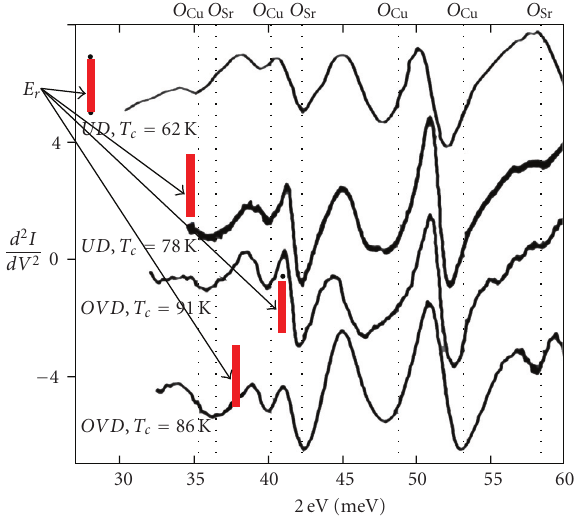
Figure 30: Second derivative of I ( V ) for Bi 2212 tunnelling junctions for various doping: UD—underdoped; OD—optimally doped; OVD—overdoped system. The structure of minima in d 2 I/dV 2 can be compared with the phonon density of states F ( ω ). The full and vertical lines mark the positions of the magnetic resonance energy E r ≈ 5 . 4 T c for various doping taken from Figure 29. Red tiny arrows mark positions of the magnetic resonance E r in various doped systems. Dotted vertical lines mark various phonon modes. From [55].